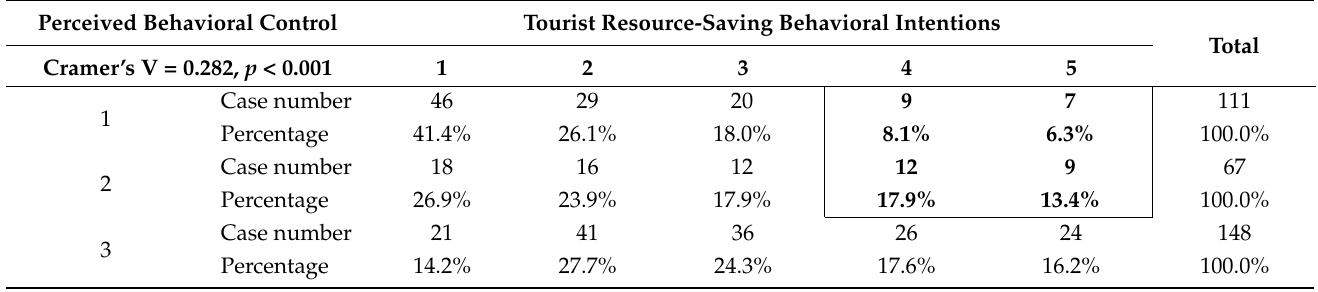
Table 7. Cross-contingency of perceived behavioral control and tourist resource-saving behavioral